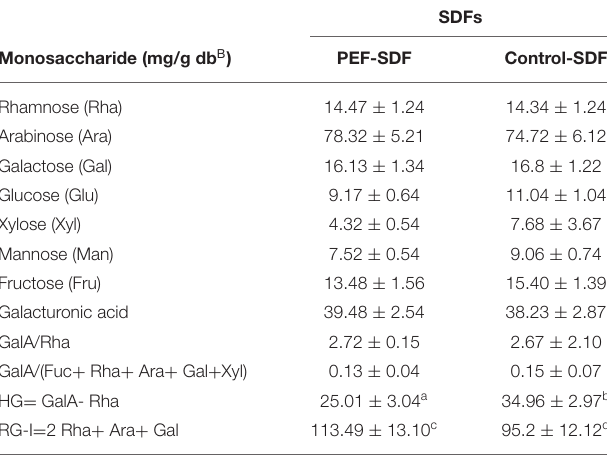
TABLE 5 | Effects of PEF A on monosaccharide constituents of orange peel